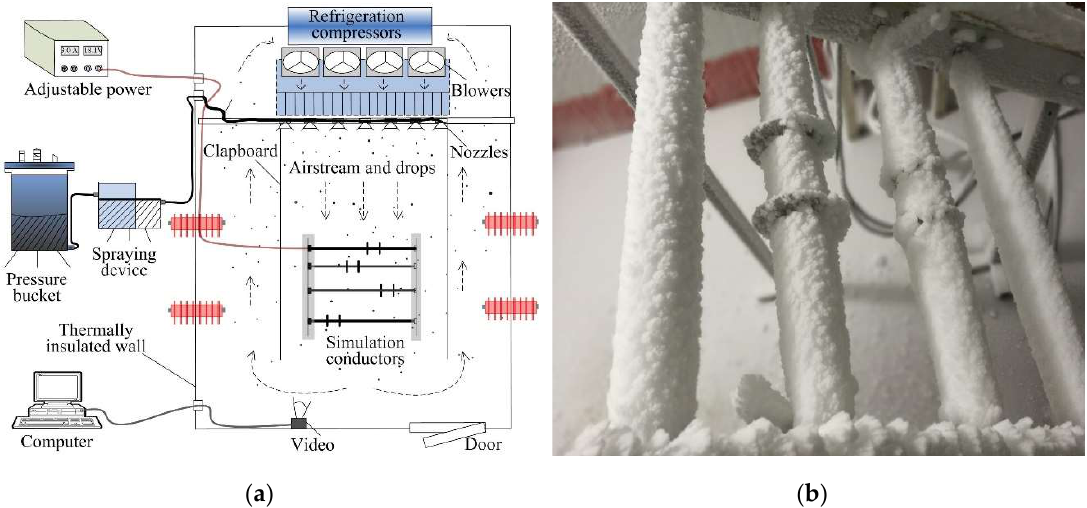
Figure 2. The artificial icing laboratory: ( a ) Schematic diagram of artificial icing laboratory; ( b ) photo of icing samples growth on the simulation conductor.